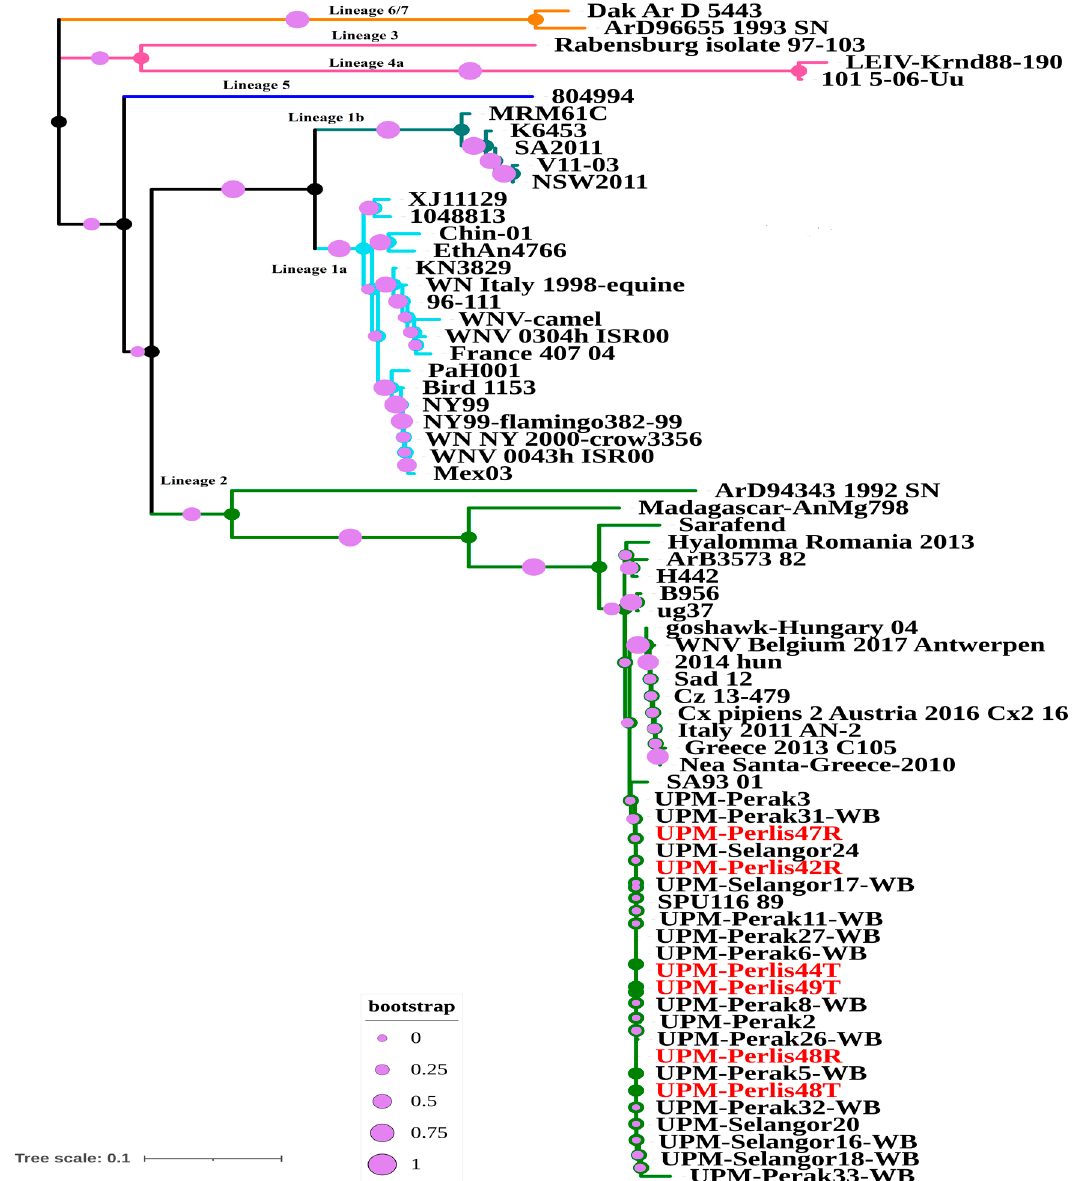
Figure 2. Phylogenetic analysis of partial sequence between capsid (C) and pre-membrane (prM) genes of West Nile Virus detected in bats in Malaysia with other global WNV isolates. The analysis involved 69 nucleotide sequences including six sequences from this study (highlighted in red), which have a 470-bp nucleotide length obtained from the bats. The tree branches were colored by the proposed WNV lineages; orange: Lineage 6/7; hibiscus: Lineage 3 and lineage 4a; blue: Lineage 5; dark cyan: Lineage 1b; sky blue: Lineage 1a; and green: Lineage 2. All the WNV sequences detected from bats are identical to the previous study, which was detected in migratory birds and the SPU 116 98 strain from South Africa. Branches are scaled bootstrap.